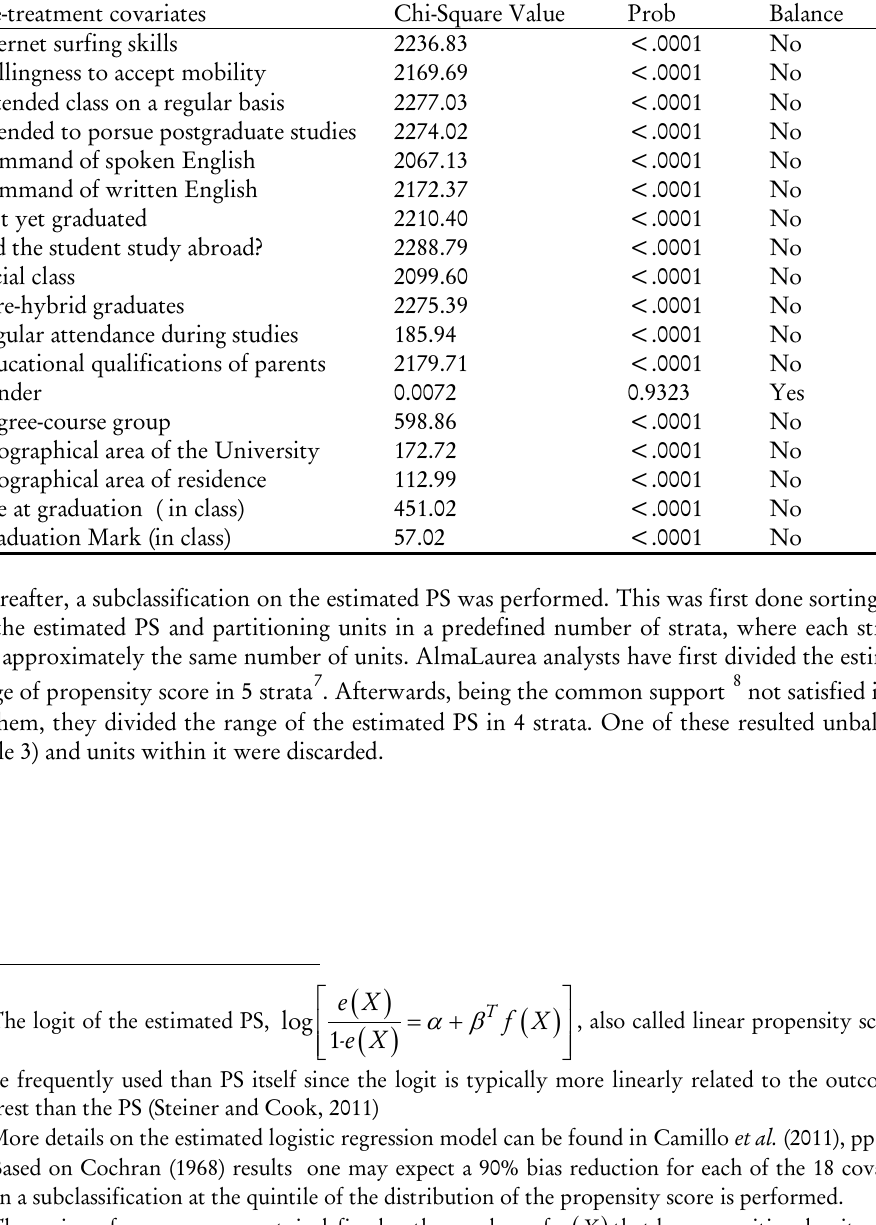
Variable-by-variable balance checking: pre-treatment covariates vs interview mode Pre-treatment covariates Chi-Square Value Prob Balance Internet surfing skills